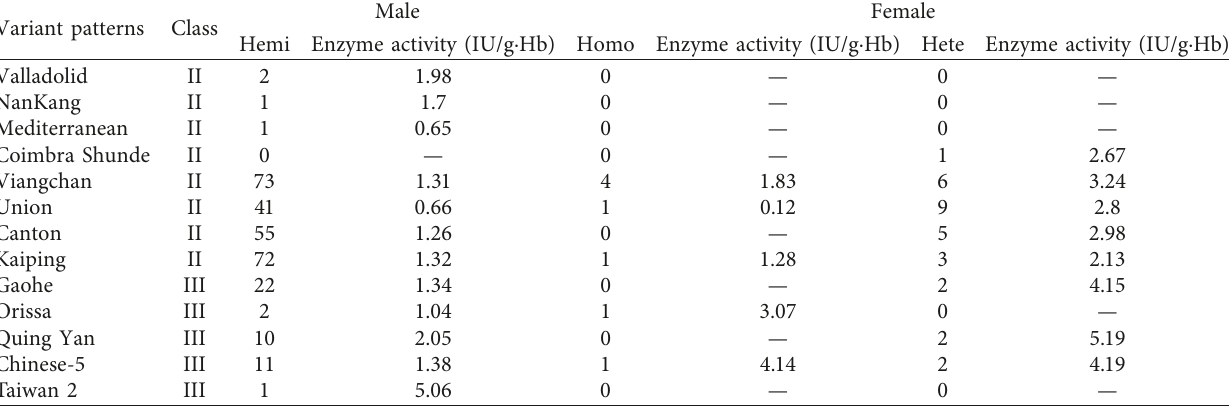
Table 3: Variant patterns of G6PD and corresponding enzyme activities.